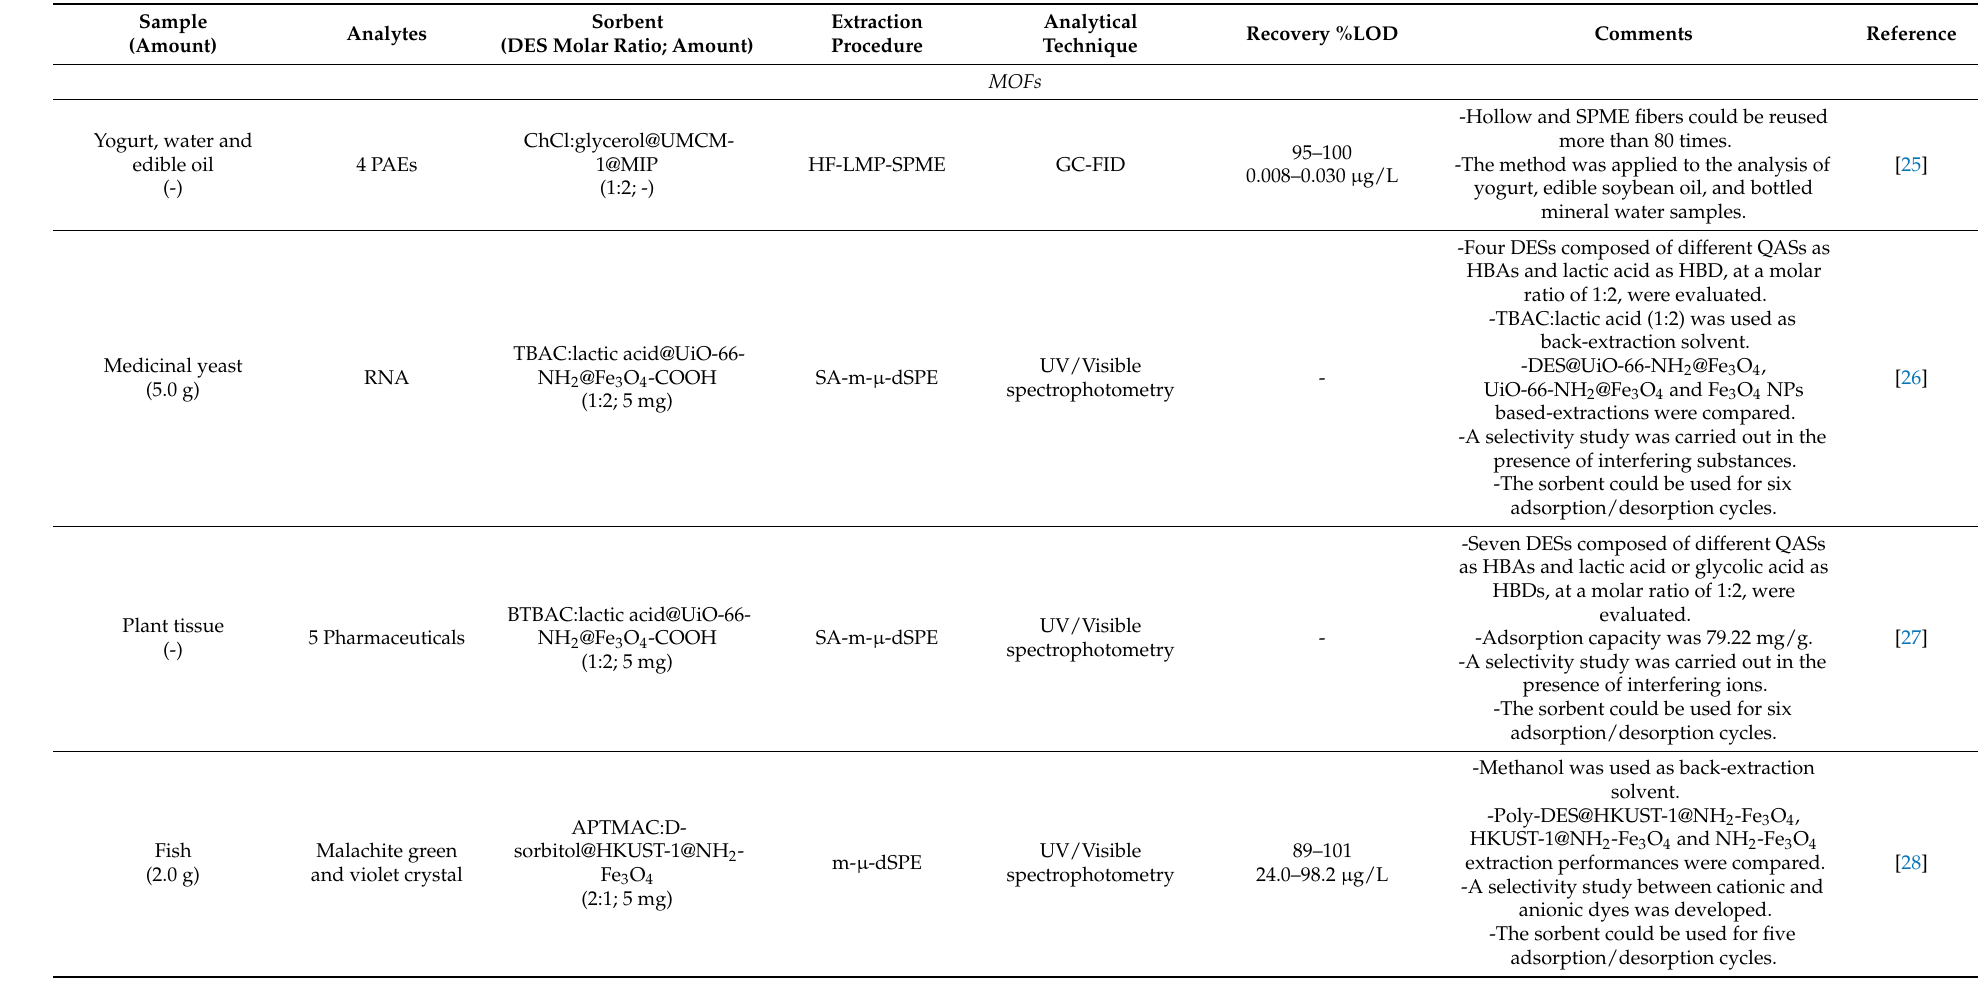
Table 2. Some examples of the application of innovative combinations of MOFs and carbon-based nanomaterials with DESs in food